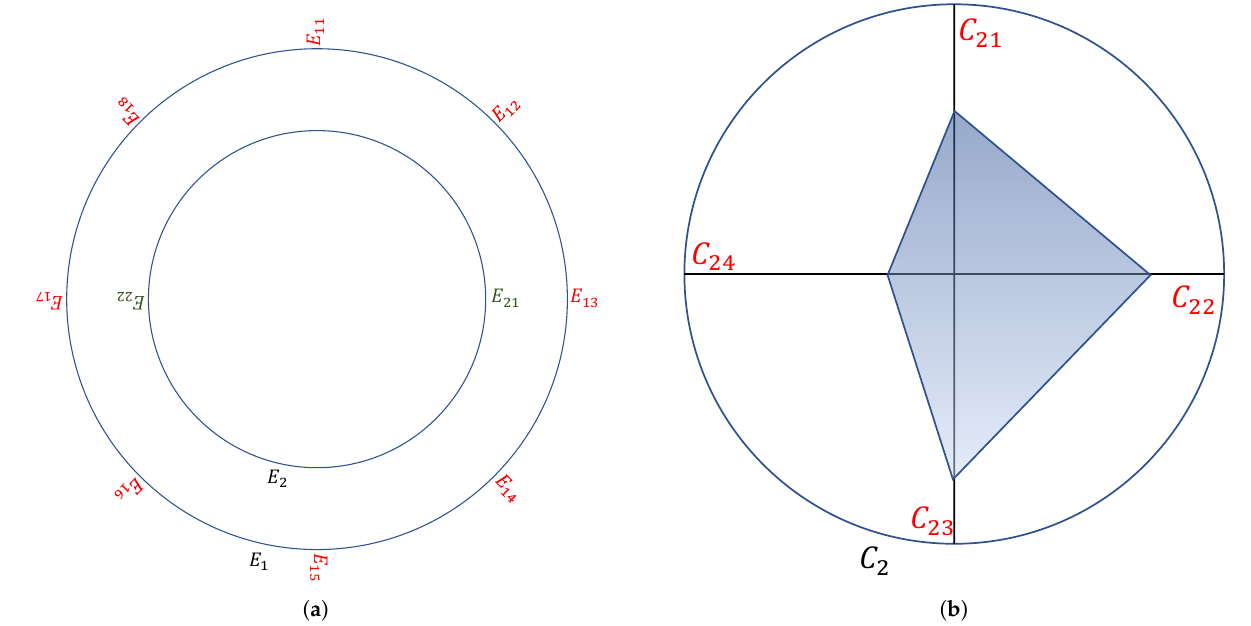
Figure 2. General concept of tools. ( a ) Dependency Nested Ring Concept; ( b ) Radar Graph Concept to analyze each alternative E ij